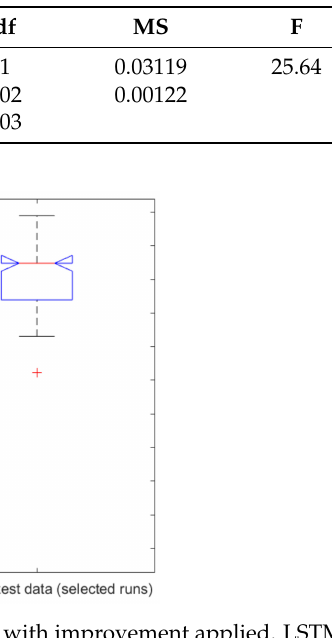
Figure 3. F1 score: test data, 52% runs with improvement applied. LSTM versus TPE-LSTM. Table 8. ANOVA